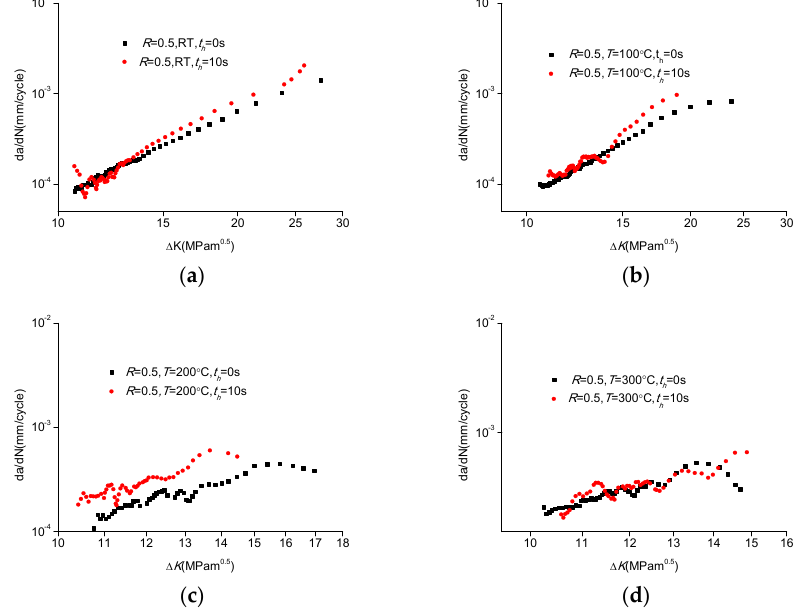
Figure 12. The effect of dwell time on CP-Ti FCG at different temperatures under high load ratio: ( a ) RT; ( b ) 100 °C; ( c ) 200 °C; ( d ) 300 °C.